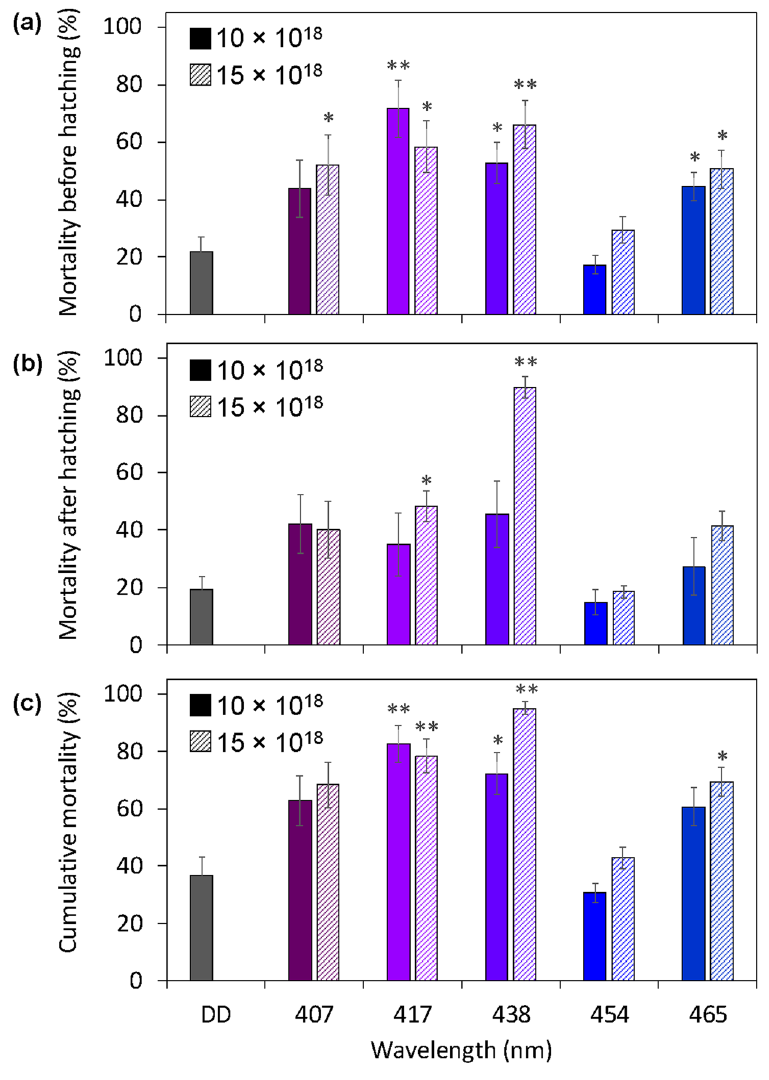
Figure 1. Mortality of beetles that were irradiated with blue light during the egg stage. ( a ) Mortality of beetles that died before hatching. ( b ) Mortality of beetles that died after hatching. ( c ) Cumulative mortality of beetles that died before eclosion. Data are means ± standard error (SE). Inset numbers (10 and 15 × 10 18 ) indicate photon flux density (photons·m − 2 ·s − 1 ). Asterisks above the bars indicate significant differences between the treatments with irradiation and dark conditions (Steel test: * P < 0.05, ** P < 0.01). DD indicates dark conditions. Nine replications (20 eggs/replicate) were